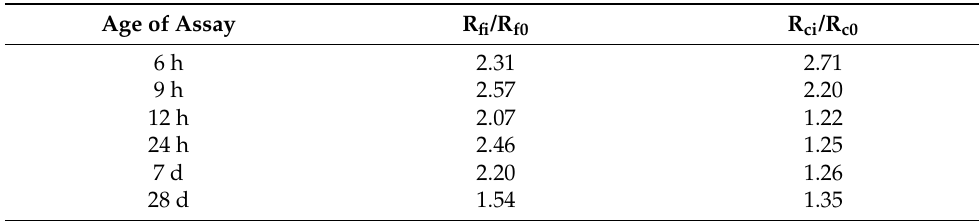
Table 6. Ratio of resistance between mortar with and without metallic fibers. Age of Assay R fi /R f0 R ci /R